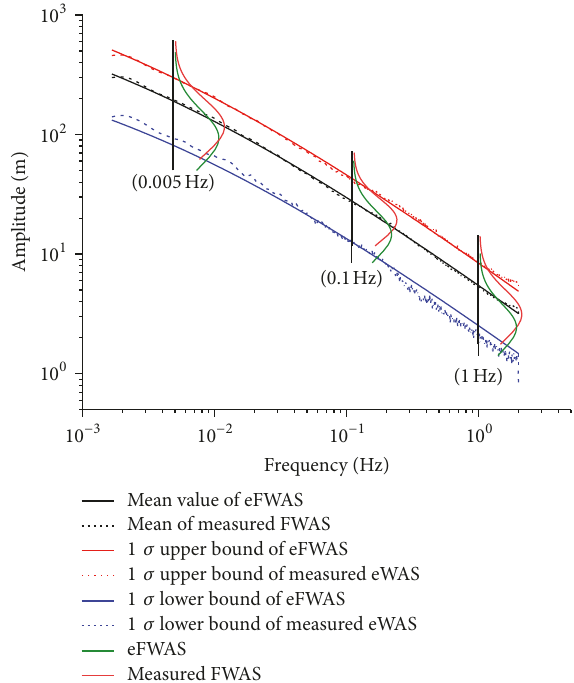
Figure 13: Statistical characteristic comparison of eFWAS and measured FWAS.